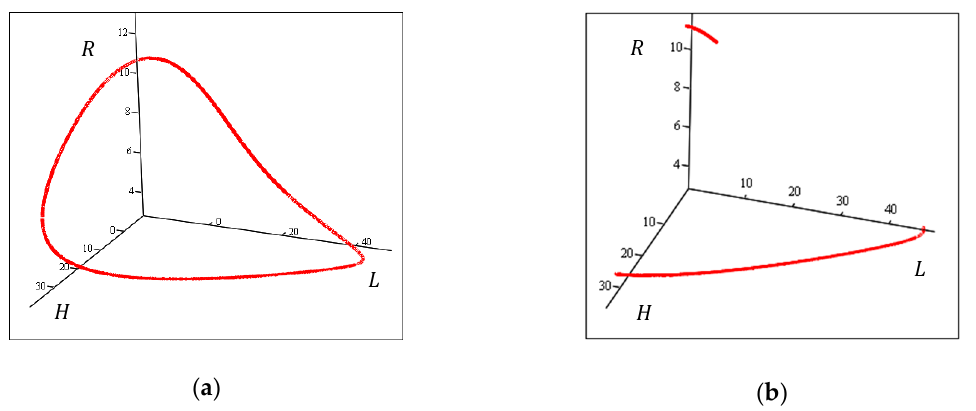
Figure 20. A 3d-plot of the solution area ( H , L , R ) : ( a ) region of the correct solutions; ( b ) region of the solutions with physical